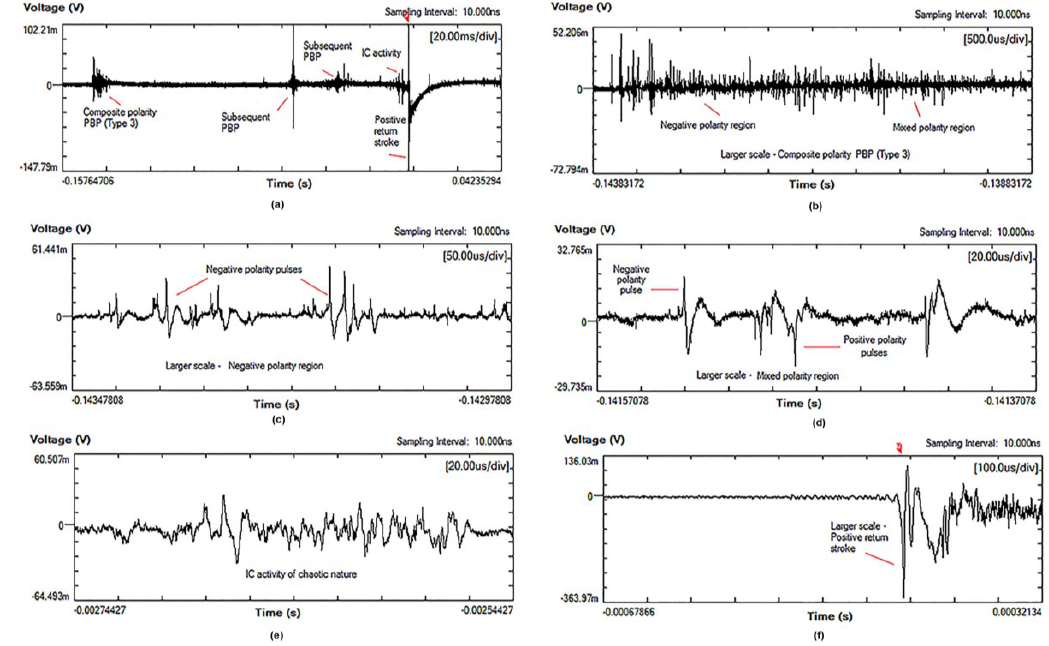
Figure 5. ( a ) Type 3 PBP—Composite polarity PBP; ( b ) Zoom in of PBP train having 2 different regions; ( c ) Zoom in of the first region showing PBP pulses with opposite polarity from the positive RS; ( d ) Zoom in of the second region showing pulses with mixed polarity; ( e ) Zoom in of IC activity; ( f ) Zoom in of positive RS.